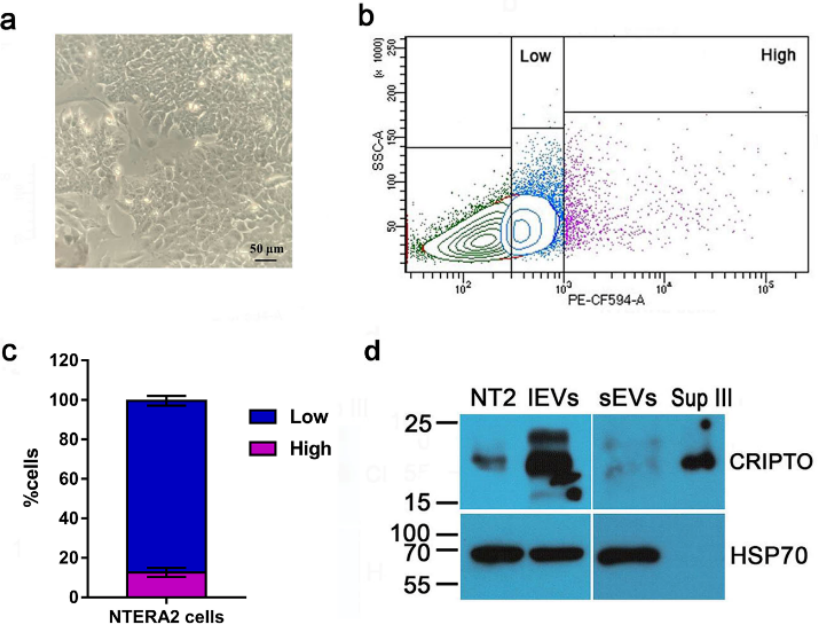
Figure 6. CRIPTO protein distribution in NTERA2 cell line. ( a ) Representative image of NTERA2 cell culture. ( b ) Flow cytometry analysis of CRIPTO protein presence on the cell membrane of NTERA2 cells. Two populations of CRIPTO positive cells (high and low), exposing different levels of the protein on the membrane, were distinguished by the respective gates. ( c ) Distribution of the CRIPTO high and low populations. The results are a mean of three independent experiments. ( d ) Equal protein amounts (20 ug) of NTERA2 cell lysates (NT2), large extracellular vesicles (lEVs), small extracellular vesicles (sEVs), and supernatant at the end of the centrifugation procedure (Sup III) were immunoblotted with an antibody against CRIPTO or against the EV marker heat shock protein 70 (HSP70).